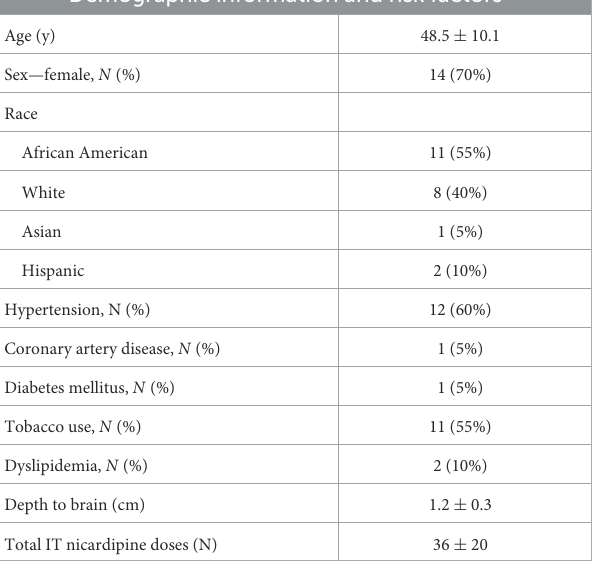
TABLE 1 Summary of patient